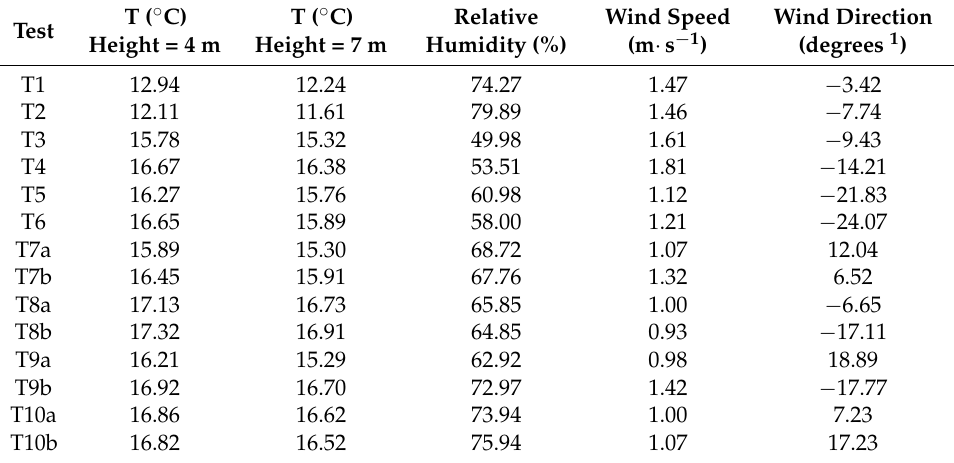
Table 3. Average micrometeorological conditions during the tests.